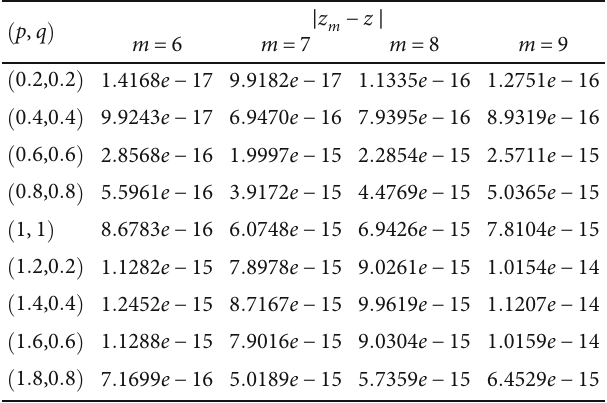
Figure 6: Charts of absolute error z (a) and v (b) with ρ = ω = υ = 1 for Example 9 when m = 6 . Table 7: The absolute error for di ff erent values m for Example 9 at Table 9: The MAE, C -order, and CPU time of the presented various points ð p , q Þ . method in Example